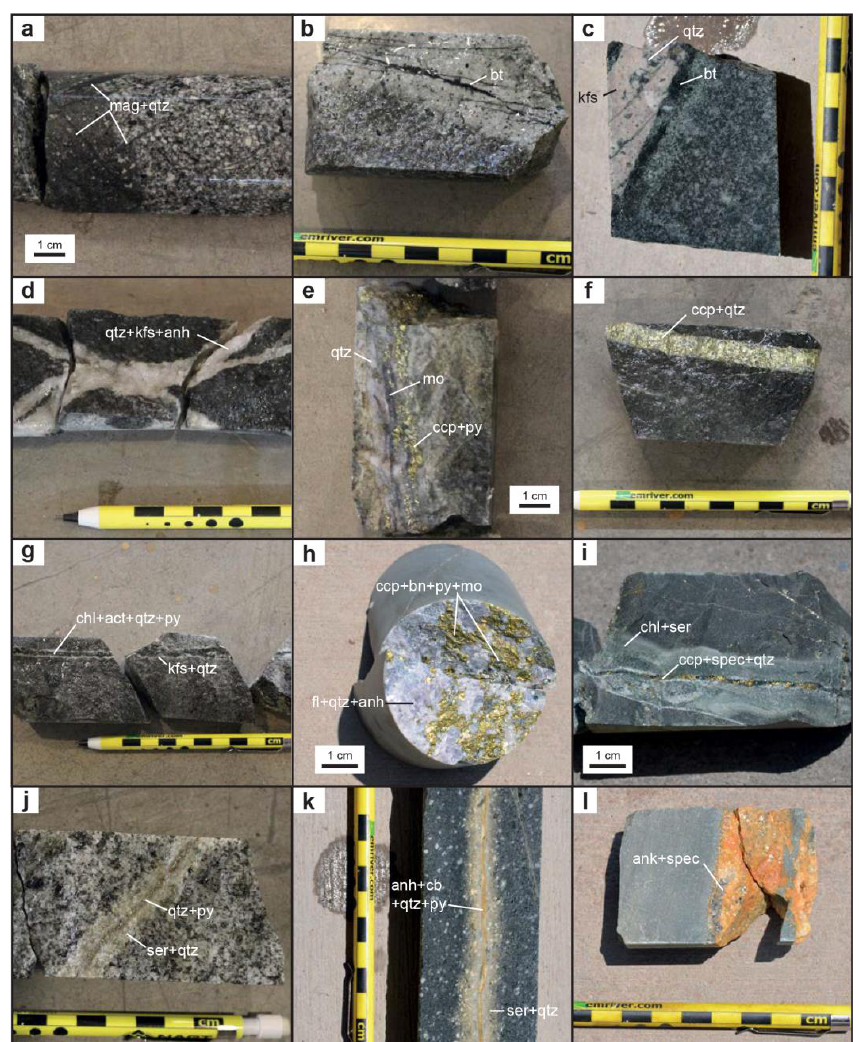
Figure 5. Examples of vein types from the Don Manuel core. ( a ) Type 1 veins containing magnetite and quartz in an IPD (DM2AG45). ( b ) Type 2 vein containing biotite in an IPD (DM8AG18). ( c ) Type 3 vein containing K-feldspar + quartz + biotite with a biotite halo in an IPD (DM8AG32). ( d ) Type 4a vein containing quartz + K-feldspar + anhydrite in an IPD (DM3AG41). ( e ) Type 4a vein containing quartz + chalcopyrite + pyrite + molybdenite in an IPD (DM8AG22). ( f ) Type 4b vein containing chalcopyrite and quartz in an IPD (DM8AG07). ( g ) Type 5 vein containing chlorite + actinolite + quartz + pyrite with a halo of quartz and K-feldspar in an IPD (DM2AG24). ( h ) Type 6 vein containing quartz + anhydrite + chalcopyrite + bornite + pyrite + molybdenite in sedimentary hornfels (DM7AG25). ( i ) Type 7 vein containing chalcopyrite + specularite + quartz with a chlorite and sericite halo in sedimentary hornfels (DM5AG05). ( j ) Type 7 vein containing quartz + pyrite with a halo of sericite and quartz in the equigranular biotite tonalite (DM2AG04). ( k ) Type 8 vein containing anhydrite + carbonate + quartz + pyrite with a sericite and quartz halo in IPD (DM6AG36). ( l ) Type 8 vein containing ankerite and specularite within sedimentary hornfels (DM7AG24). Mineral abbreviations: mag = magnetite, qtz = quartz, bt = biotite, kfs = potassium feldspar, anh = anhydrite, mo = molybdenite, ccp = chalcopyrite, py = pyrite, bn = bornite, chl = chlorite, spec = specularite, ser = sericite, cb = carbonate, and ank =